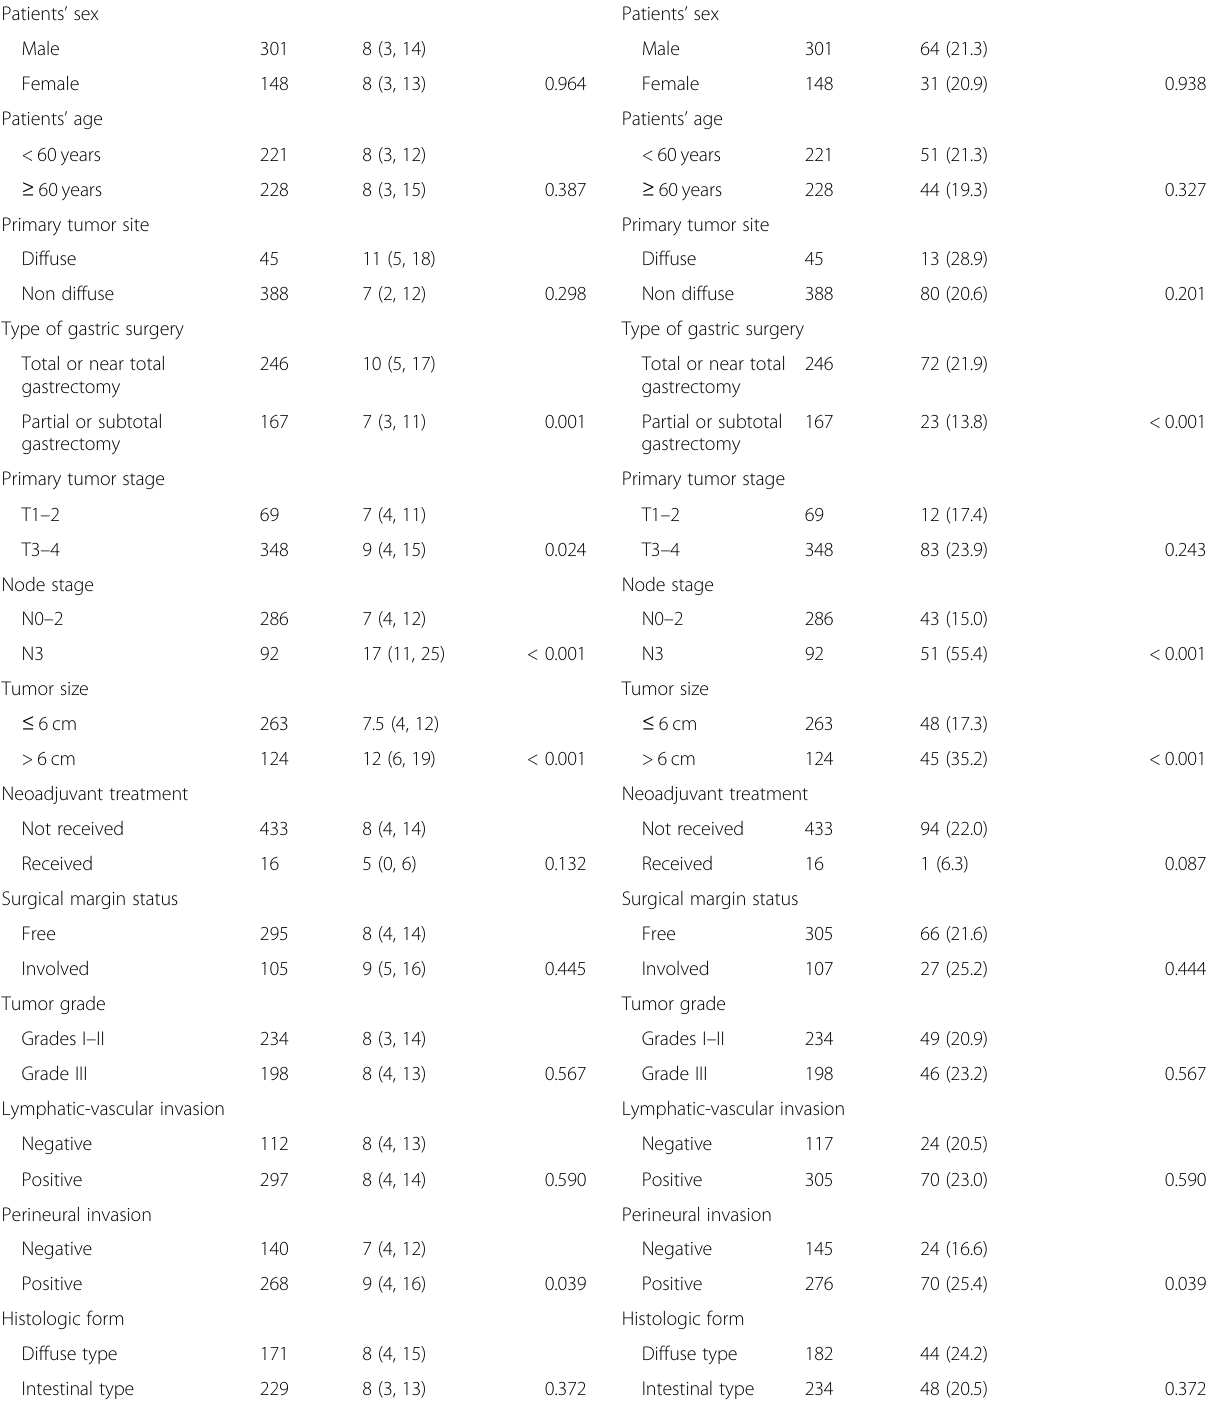
Table 2 Association of potential variables on median total lymph node count in 449 patients with resected gastric adenocarcinoma